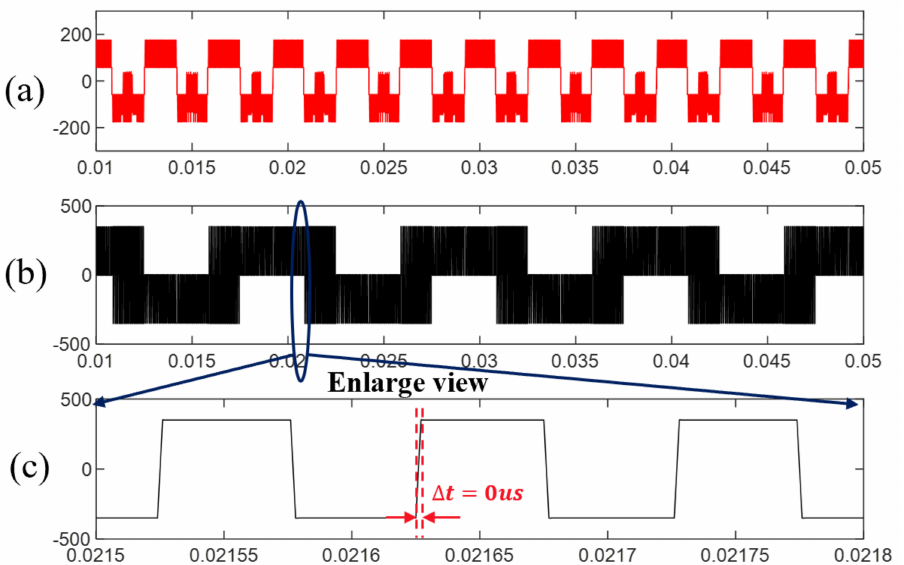
Figure 14. TSPWM without zero-voltage time interval optimization (M = 0.6): ( a ) common voltage; ( b ) line–line voltage; ( c ) enlarge view of line–line voltage.